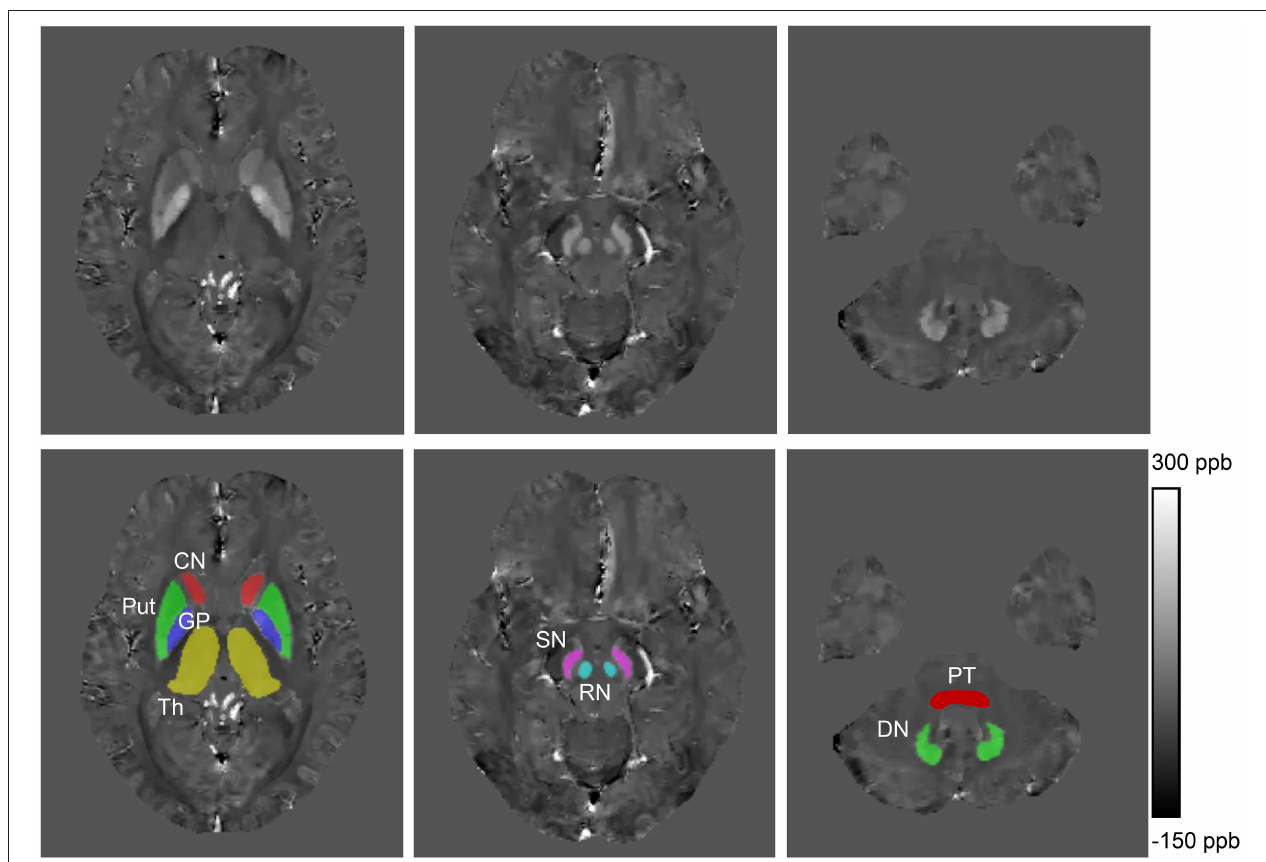
FIGURE 1 | Example images showing regions of interest from a healthy control (41 years old, male). CN, head of the caudate nucleus; DN, dentate nucleus; GP, globus pallidus; Put, putamen; RN, red nucleus; SN, substantia nigra; Th, thalamus; PT, pontine tegmentum; ppb, part per